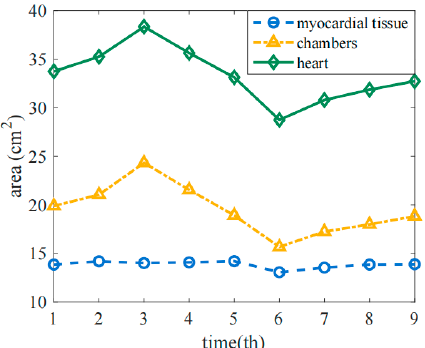
Figure 2. The change curve of the cross-sectional area of each heart chamber in a cardiac cycle.